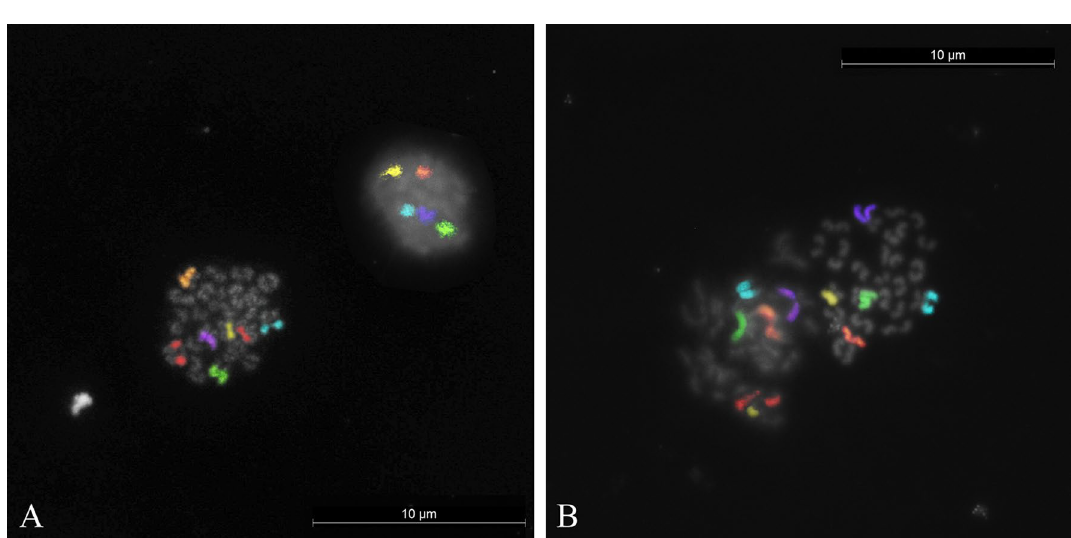
Figure 3. Aberrant secondary oocyte metaphases for the heterosome X (red color); ( A ) disomy in river buffalo (MII,25,X,+X); ( B ) nullisomy in swamp buffalo